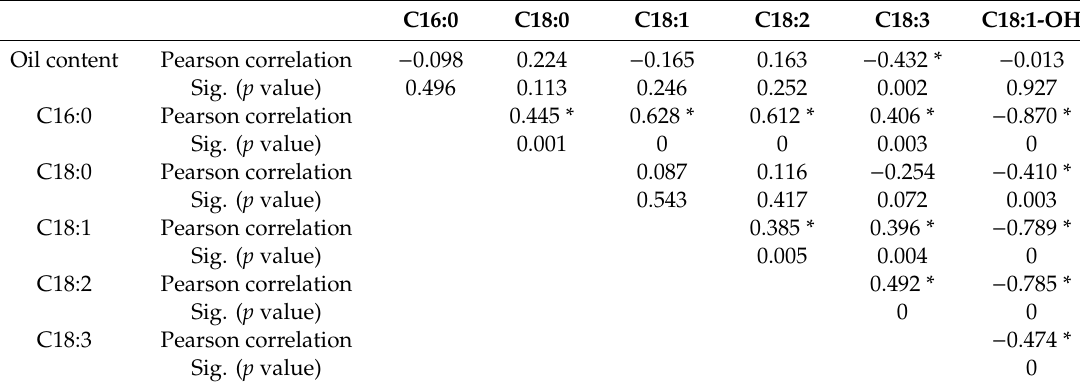
Table 3. Pearson correlation coe ffi cients comparing oil content (%) and fatty acid content (%) registered in the 17 castor Chilean